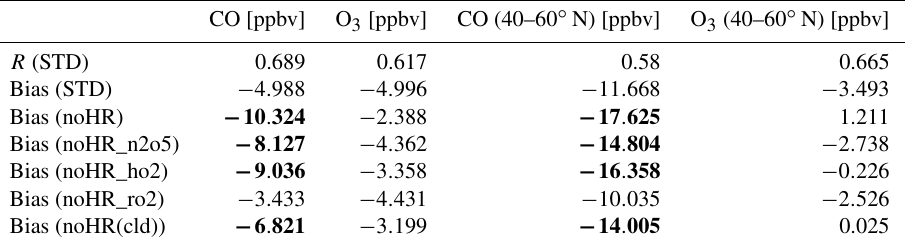
Table 7. Model correlations and biases for Mirai . No outlier filtration is applied. The bias of the sensitivity run is shown in bold if it is higher than the bias of STD run. R has no unit; the units in brackets are for